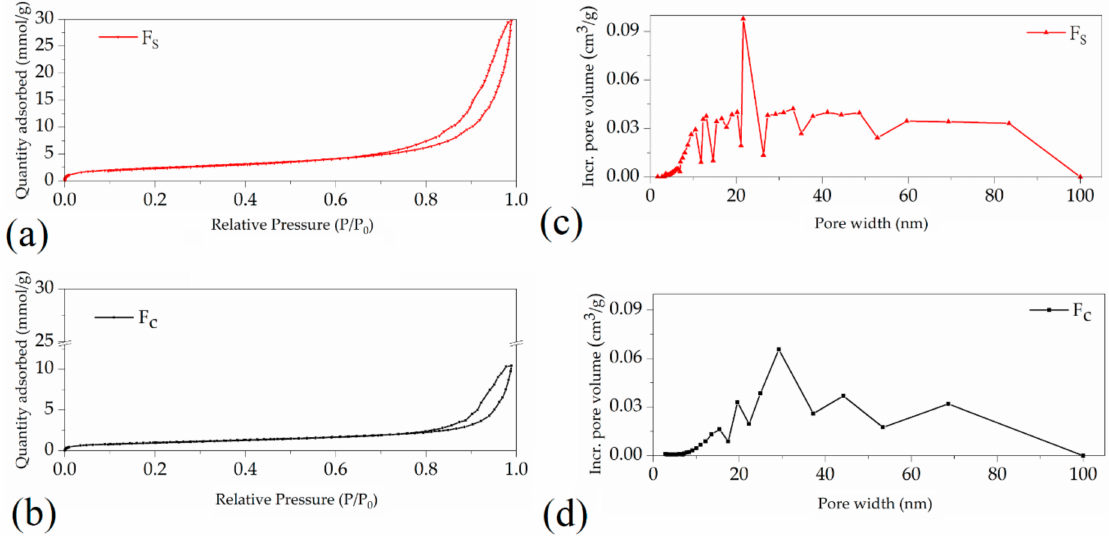
Figure 7. Nitrogen adsorption-desorption isotherms curve and representation of pore size distribution by incremental pore volume versus pore size width of F s ( a , b ) and F c ( c , d ). In contrast to F c , the F s had a higher N 2 quantity adsorbed. The majority of pores were distributed under 50 nm in both samples and F s had a higher pore volume. The specific surface area of F s and F c was 197 m 2 /g and 85 m 2 /g, respectively.